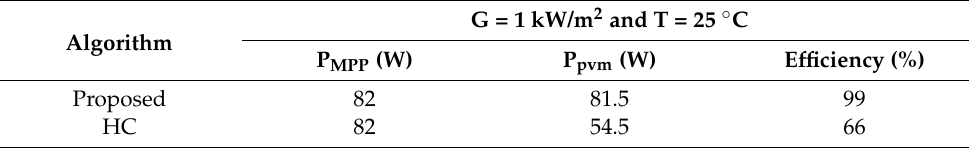
Table 6. Comparison of two algorithms’ MPPT efficiency under